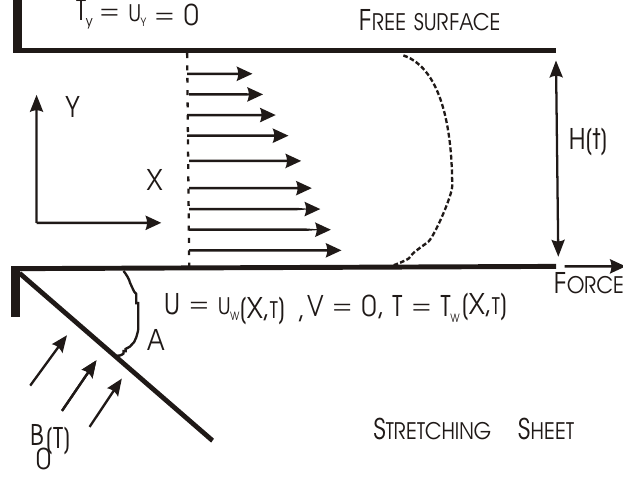
Figure 1. Geometry of the unsteady